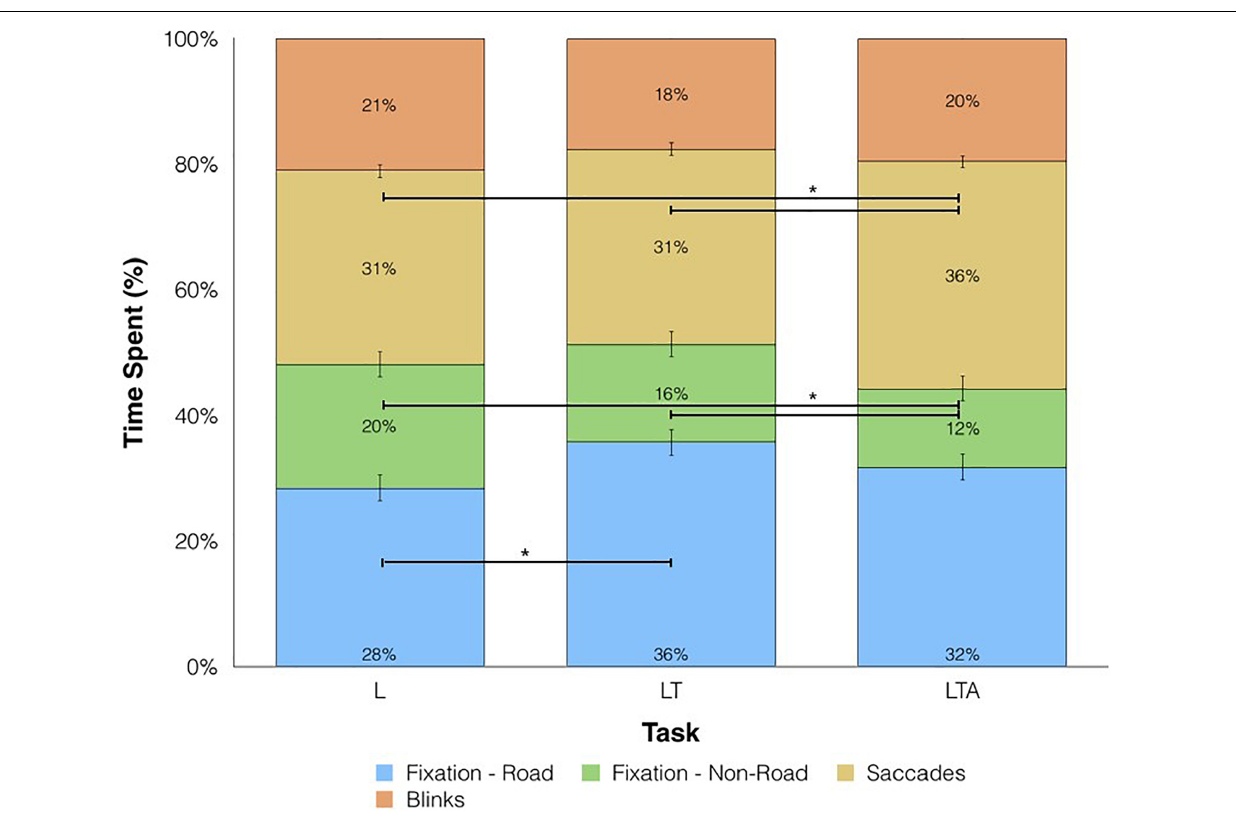
FIGURE 6 | Percentage of time spent on eye movements for L, left turns; LT, left turns with oncoming traffic; and LTA, left turns with oncoming traffic and auditory distraction. Fixations on the road are shown in blue, fixations away from the road are shown in green, saccades are shown in yellow and blinks are shown in orange. Horizontal bars and asterisks represent statistically significant differences at p <